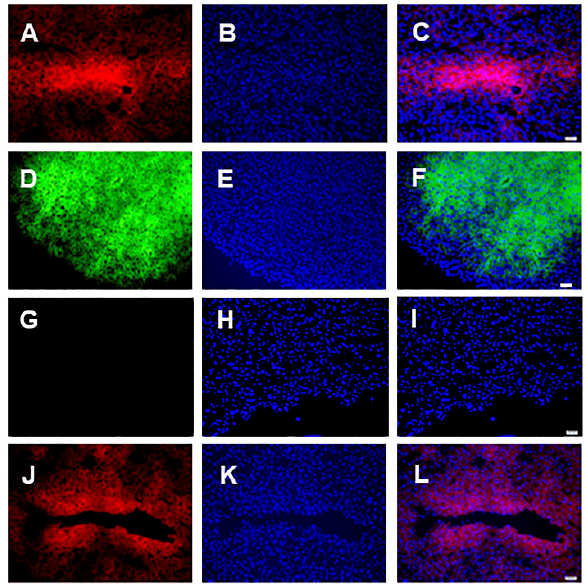
Figure 1. Immunofluorescence detection of marker gene expression in NOD mouse livers following transduction with AAV vectors. Frozen sections of mouse liver were prepared for immunofluorescence detection and visualised by fluorescence microscopy. ( A ) m-Cherry- INS-FUR immunofluorescence 9 weeks after intial transduction, ( B ) DAPI-stained nuclei of A and ( C ) is a merged image of A and B. ( D ) Venus- INS-FUR immunofluorescence 9 weeks after INS-FUR and Pdx1 were delivered together. ( E ) shows the DAPI-stained nuclei of D and ( F ) is a merged image of D and E. ( G ) is a normal liver section showing no immunofluorescence for either venus or mCherry and ( H ) is an image of DAPI-stained nuclei of ( G ) and ( I ) is a merged image of ( G ) and ( H ). ( J ) piggyBac - INS-FUR -mCherry immunofluorescence 15 weeks after initial transduction, ( K ) is the DAPI-stained nuclei of ( J ) and ( L ) is a merged image of ( J ) and ( K ). Bar = 20 µm.